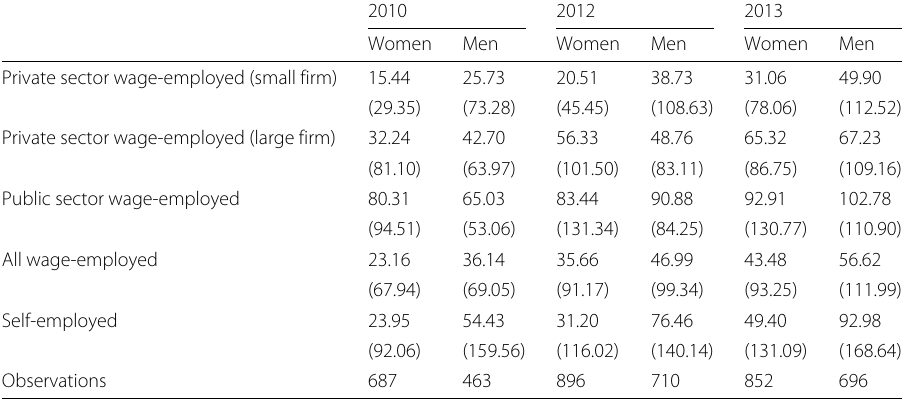
Table 2 Median weekly earnings for the self- and wage-employed 2010–2013 (2010 Ghana